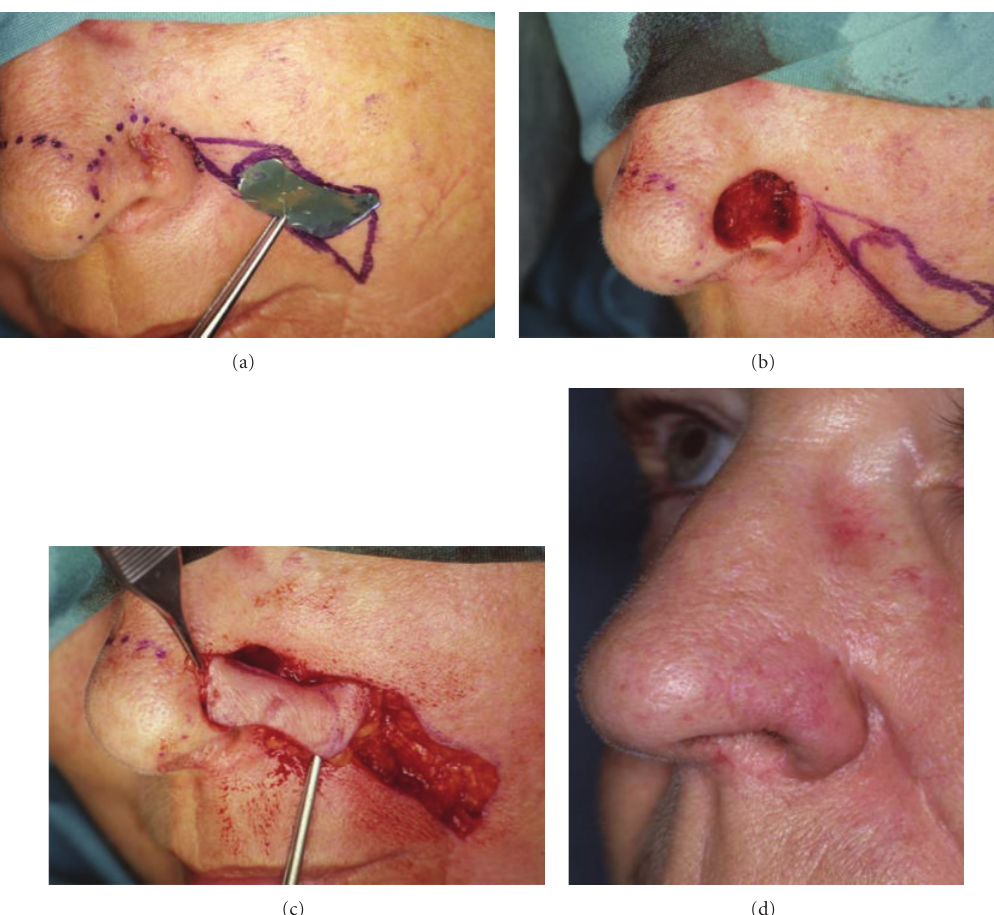
Figure 2: (a) Nasolabial flap design. (b) Tumour resection. (c) The flap is transferred to the recipient site. (d) Nasal appearance two years after